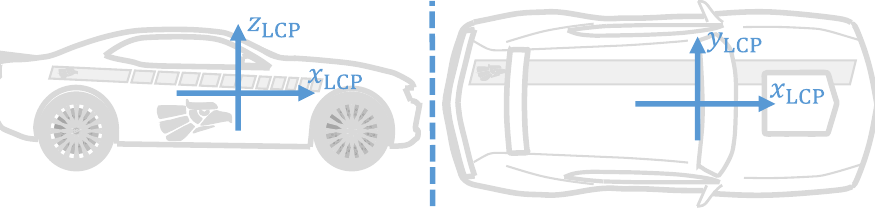
Figure 1. Graphical depiction of the Local Car Plane. The vehicles move on the Local Tangent Plane (LTP). The LTP is a Cartesian reference frame, composed by the mutually perpendicular x LTP , y LTP and z LTP axes, with −−→ −−→ x LTP × y LTP ; and with origin o LTP at an arbitrary location on the surface of the Earth. The axis orientation of the LTP is similar to the East-North-Up (ENU) reference frame, where the x LTP × y LTP -plane is perpendicular to the gravitational pull of the Earth, the y LTP axis points to the true north of the Earth, and the z LTP axis is parallel to the gravitational pull of the Earth, and points upwards.